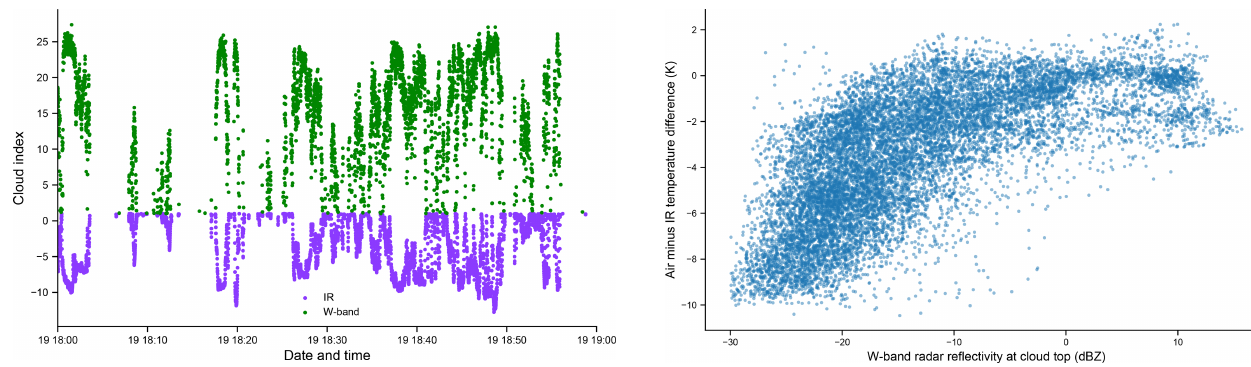
Figure 10. Cloud indexes based on radar ( C radar , green) and in- frared radiometer ( C IR , purple) measurements for the period 18:00– 19:00UTC on 19 January (cf. Fig. 6). Cloud is indicated by values of C radar > 0 and C IR < 0. Absolute values less than one have been removed for clarity. The two indexes are quite consistent with one another because clouds, when present, are typically opaque enough to be easily detectable in both infrared and microwave measure- ments.